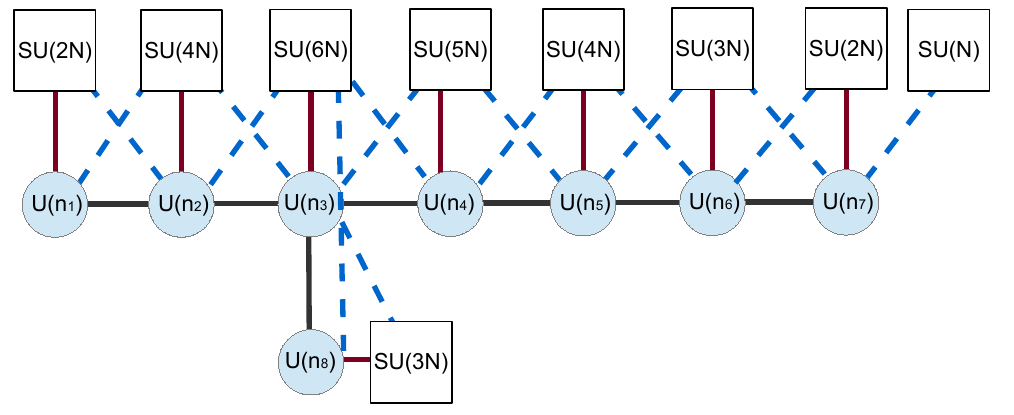
Figure 14 . Quiver gauge theory for the non-critical strings of N D5 branes probing an E